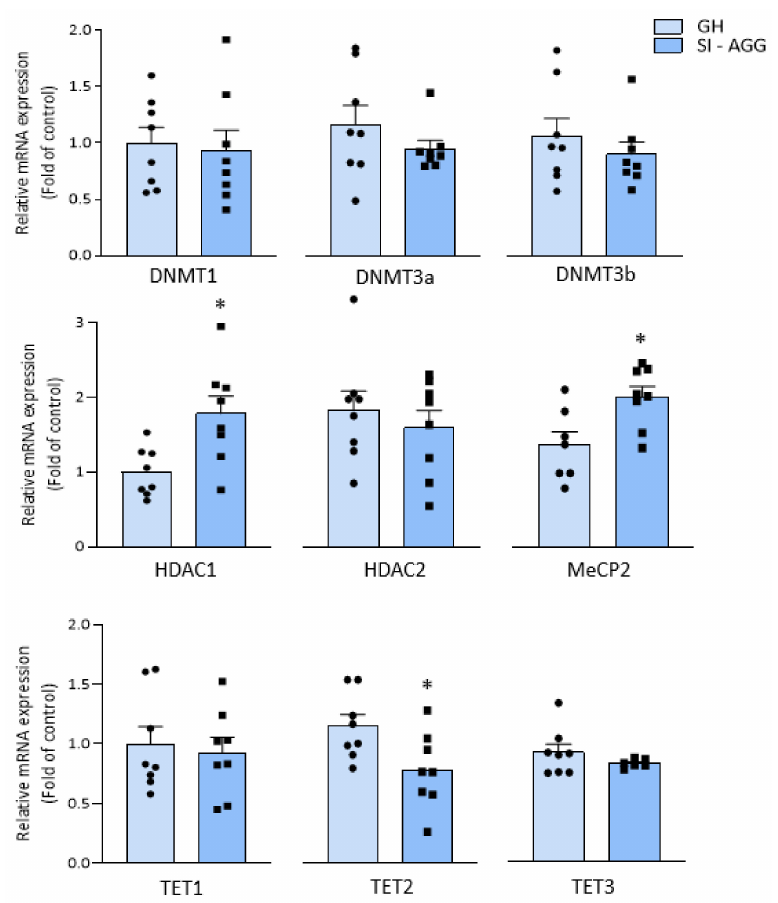
Figure 3. mRNA expressions of DNMTs, HDACs, MeCP2, and TETs in the hippocampus of SI- AGG and GH mice. Increased mRNA of HDAC1 and MeCP2 (Unpaired t test two-tailed: HDAC1: * p = 0.01; t = 2.96; df = 14; n = 8; MeCP2: * p = 0.01; t = 2.81; df = 13; n = 7–8) and decreased expression of TET2 (* p = 0.02; t = 2.46; df = 14; n = 8) were found in the hippocampus of SI-AGG mice, whereas no changes were detected in the mRNA of the DNMT enzymes. This evidence corroborates our finding supporting stress-induced epigenetic alterations leading to a PPAR- α gene hypermethylation and a decreased expression in the hippocampus of SI-AGG